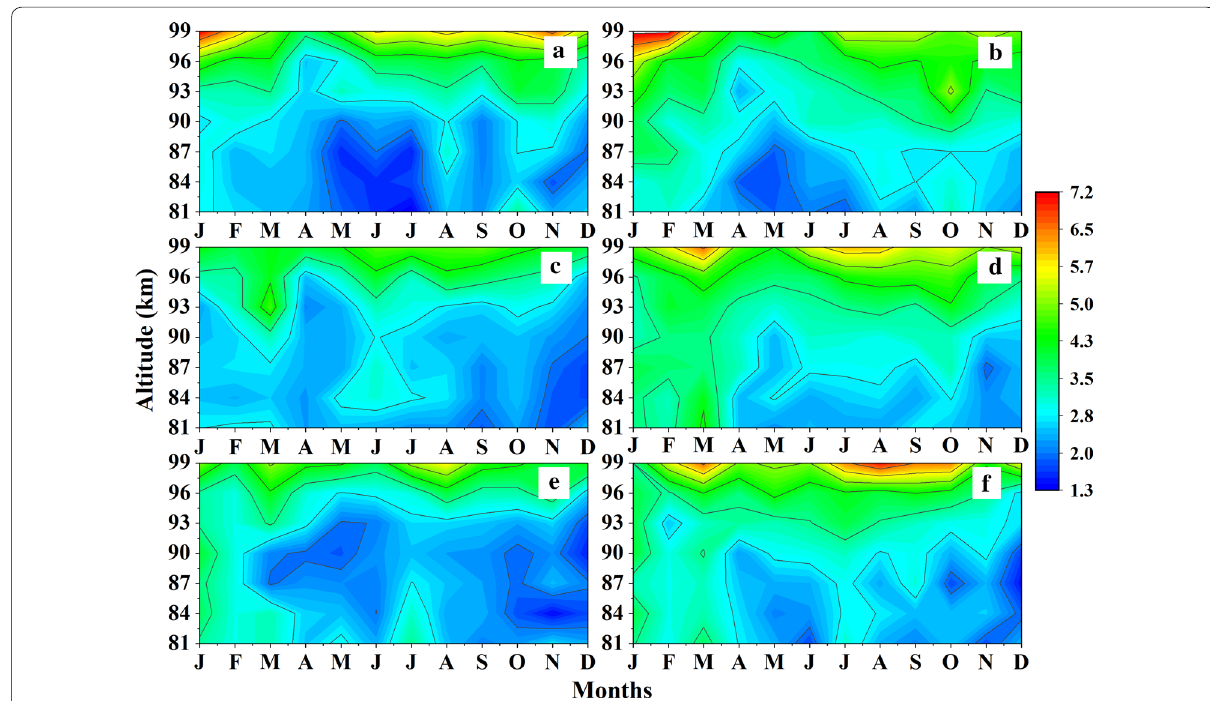
Fig. 4 Amplitude (m/s) contours with respect to the month and altitude: a zonal wind at CA, b meridional wind at CA, c zonal wind at CP, d meridional wind at CP, e zonal wind at SM and f meridional wind at